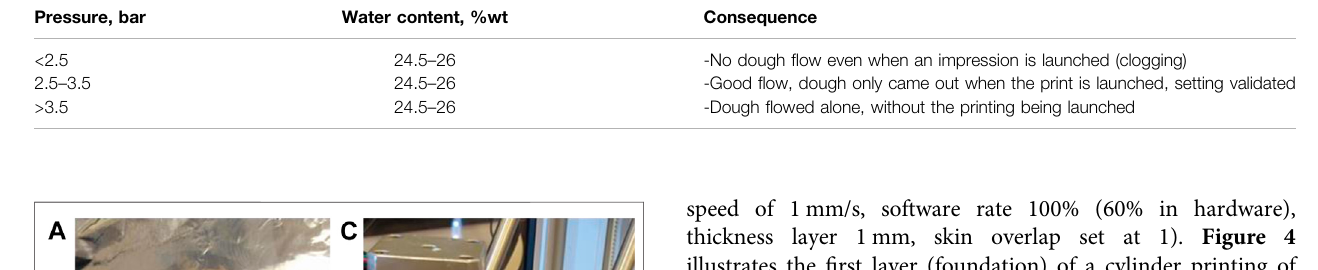
TABLE 3 | Tank inlet pressure adjustment, constant fl ow of 1 mm/s, nozzle diameter of 1.0 mm. Pressure, bar Water content, %wt